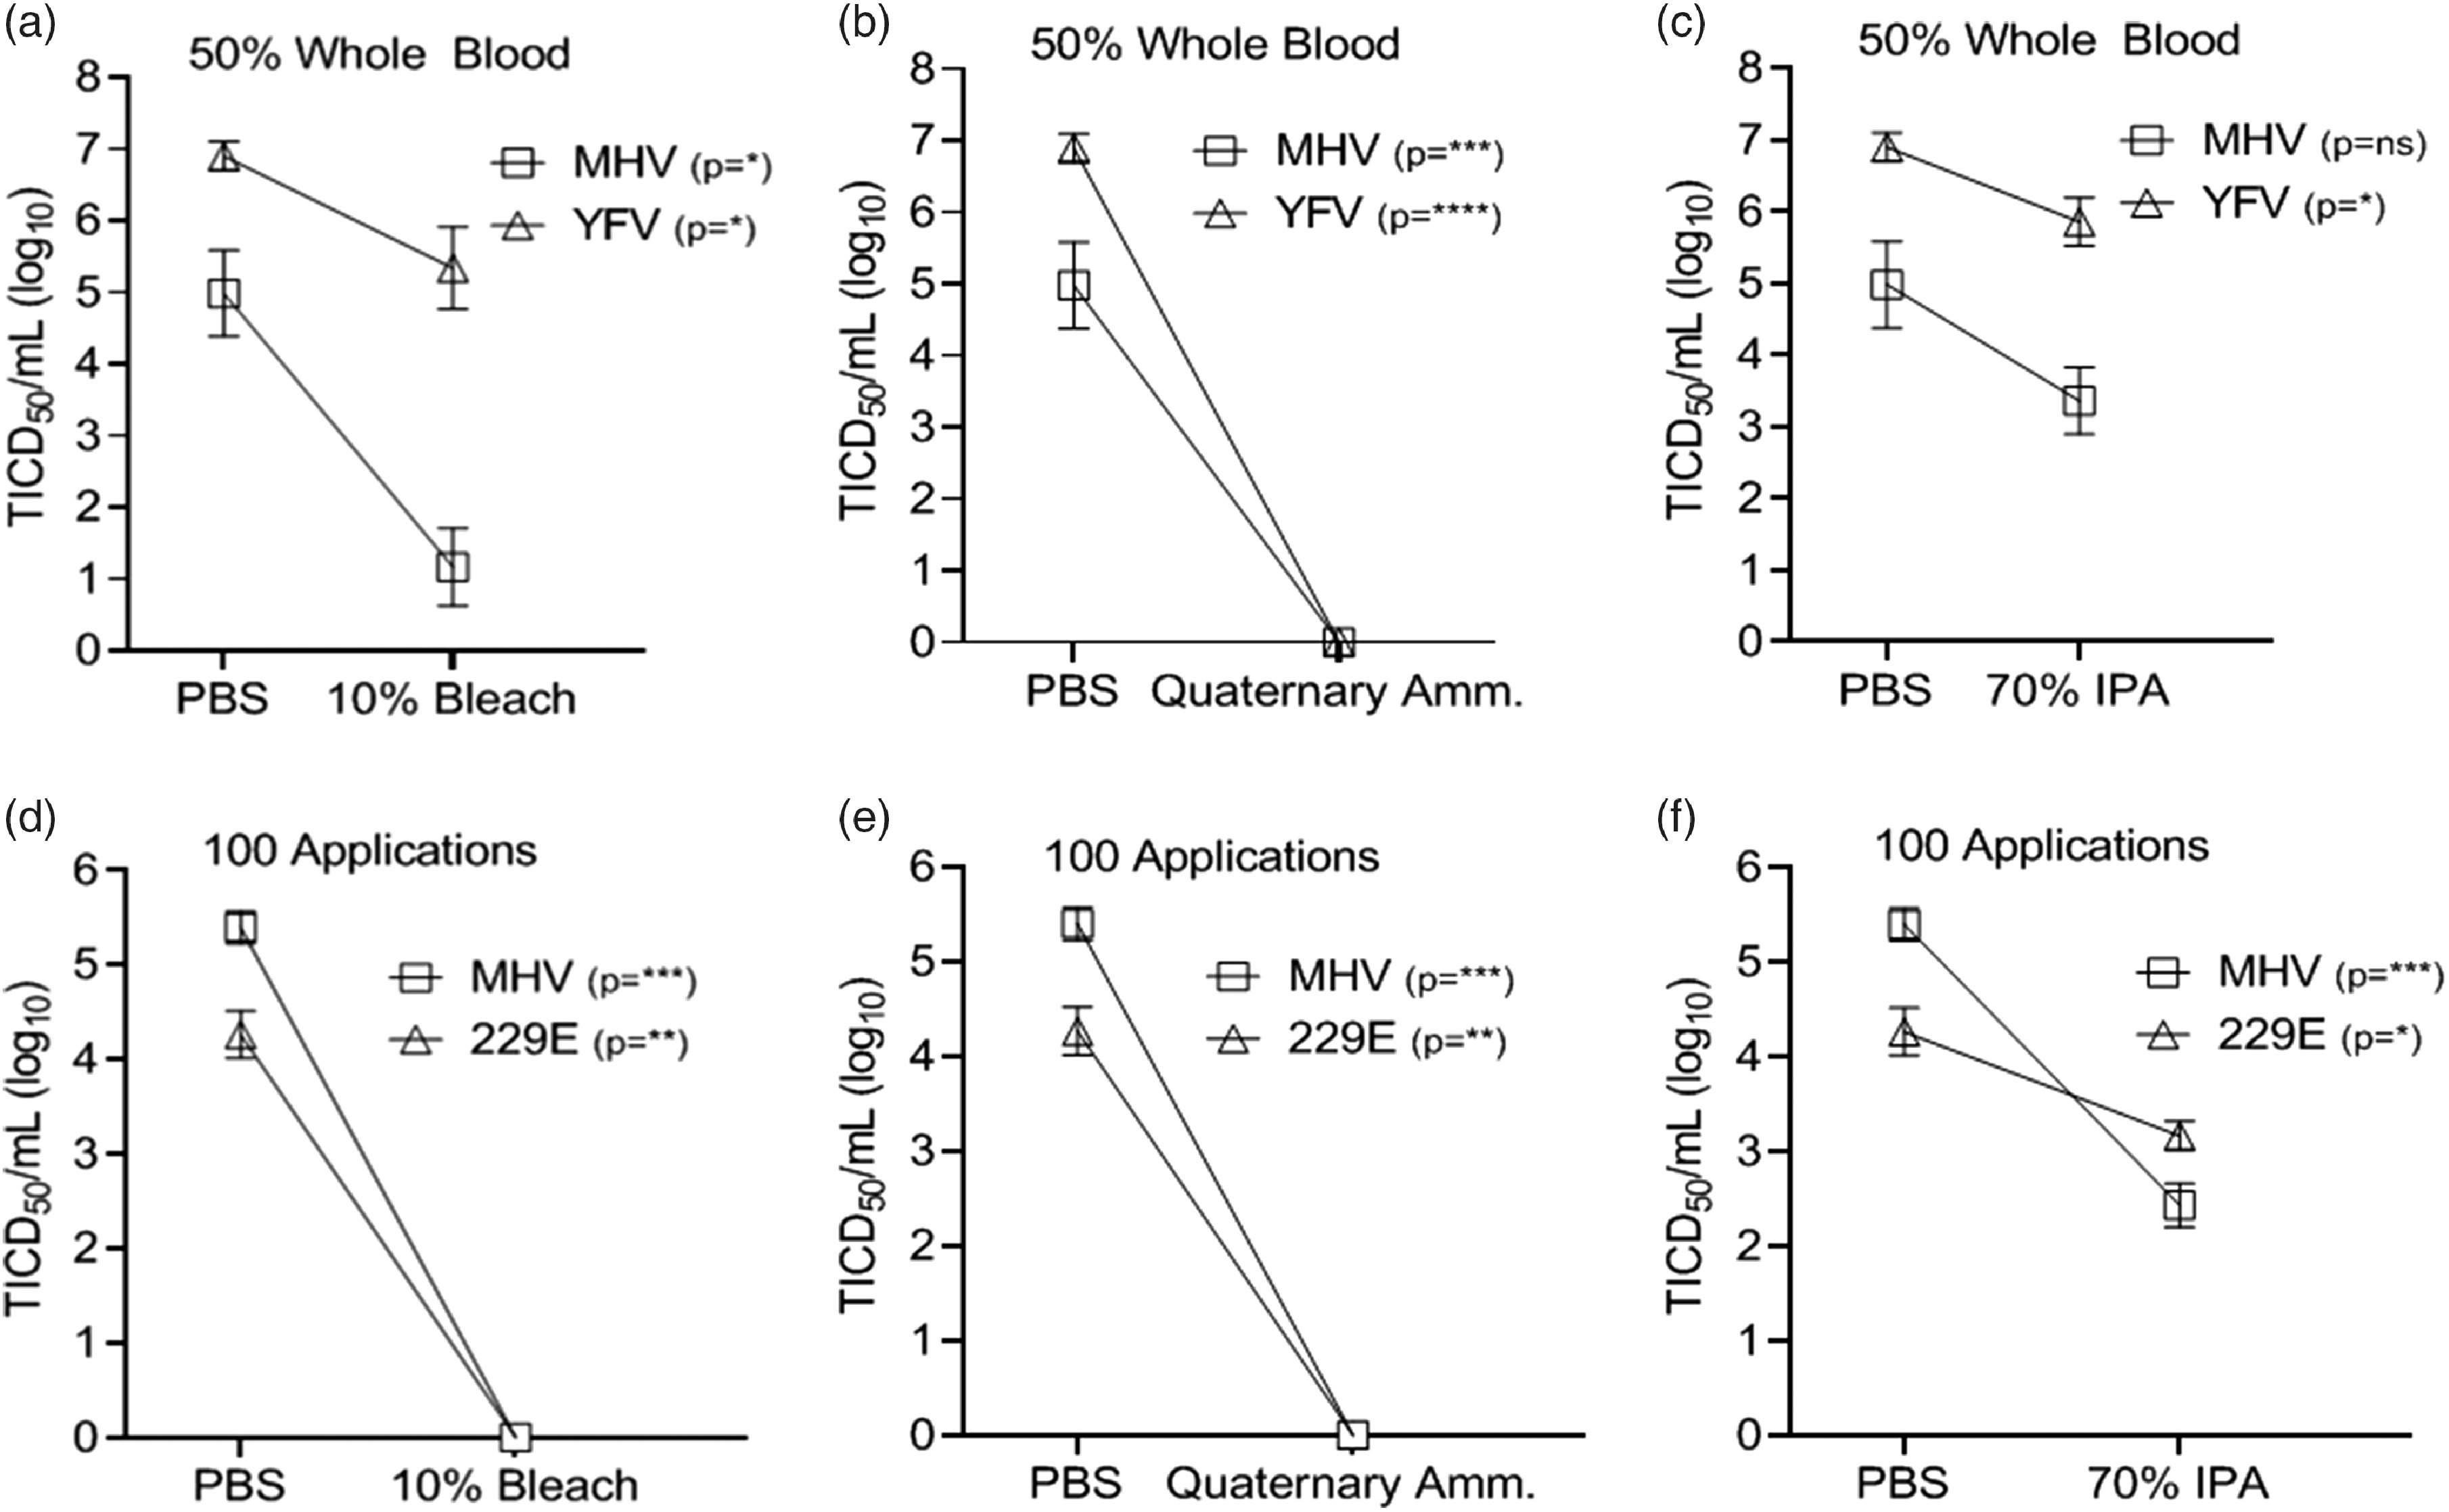
Effectiveness of chemical inactivation of viruses (log10) in the presence of blood and after repetitive disinfection of material. Virus recovery from 3D printed mask material after virus addition to whole blood (50% final concentration) and exposure to a single-wipe application of (A) 10% bleach, (B) ammonium quaternary, and (C) 70% IPA. Wipe application of PBS acted as control. Virus recovery from 3D material after the material was exposed to disinfectant 100 times prior to application of virus and a single-wipe application of (D) 10% bleach, (E) quaternary ammonium, and (F) 70% IPA. Virus titer was completed as described in the Methods section in the cell type indicated in Table 1. Significance was determined using the Student t test. *P < .05; **P< .01; ***P < .001; ****P < .0001; ns, not significant. Error bars represent standard error of the mean (SEM) of triplicate experiments.